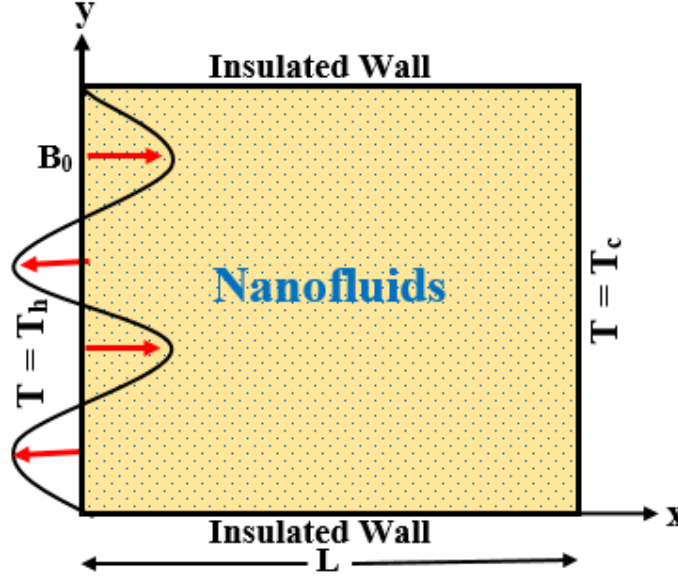
Figure 1. Schematic flow configuration and geometry. Table 1. Thermo-physical properties of the different nanoparticles and base fluids (see [17,24]).